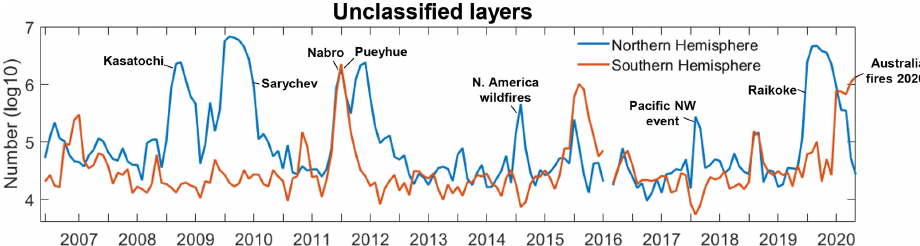
Figure 23. Number of unclassified layers in the Northern Hemisphere (blue) and Southern Hemisphere (red), excluding the SAA and layers with | CAD score | < 20. Computed using V4.2 integrated attenuated backscatter with V4.5 low- γ (cid:48) thresholds, so the figure serves as a close approximation to